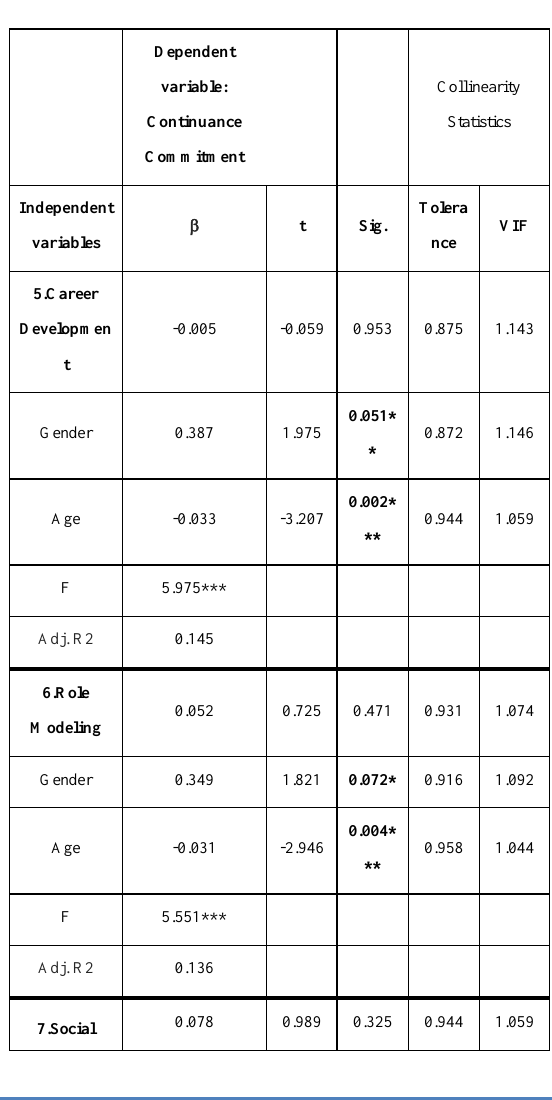
7. The Effect of Mentoring on Continuance Commitment